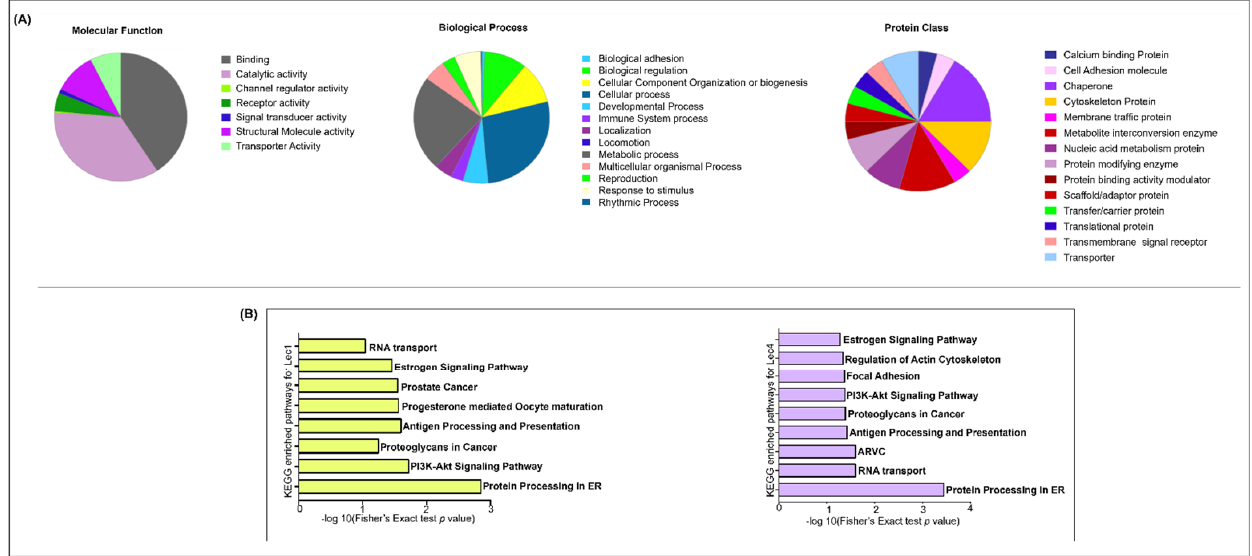
Figure 3. Functional annotation of differentially expressed proteins was analyzed via Protein Analysis through Evolutionary Relationships (PANTHER) and Database for Annotation, Visualization and Integrated Discovery (DAVID). ( A ) Molecular function, biological process, and protein class results of 37 dysregulated proteins in W5, Lec1 and Lec4 cells summarized in a pie chart using PANTHER; ( B ) biological processes in Lec1 and Lec4 based on the 44 and 43 differentially expressed proteins, depicted in a bar graph according to DAVID.